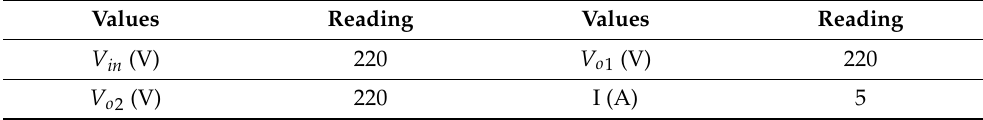
Table 2. The proposed transformer test reading.